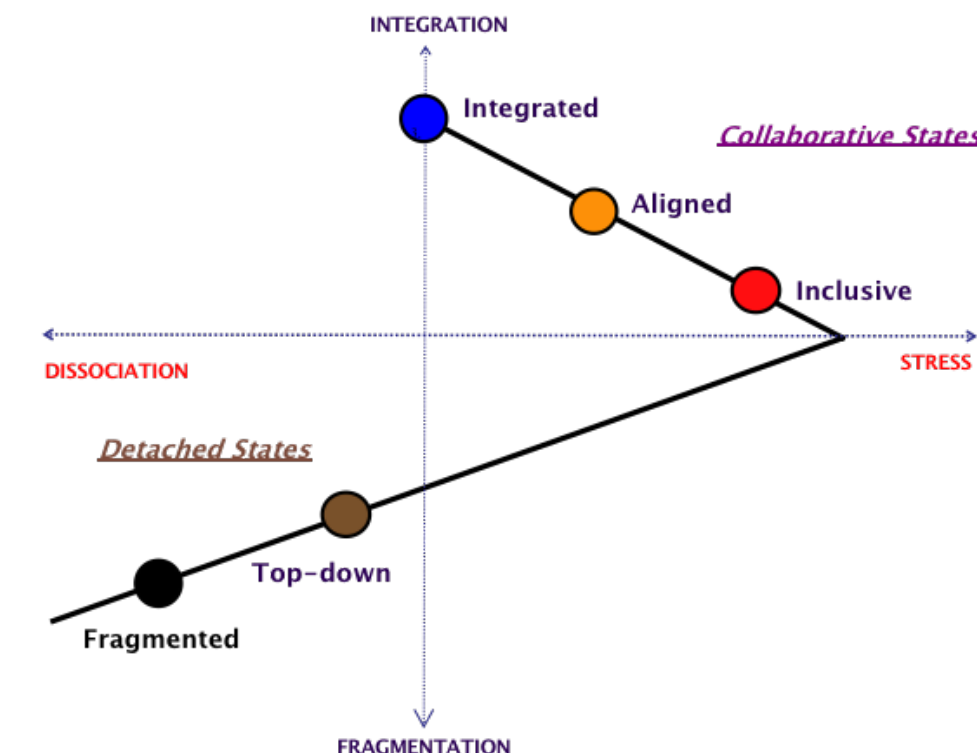
Figure 5. The y-axis: cooperative capacity, dissociation, and stress.